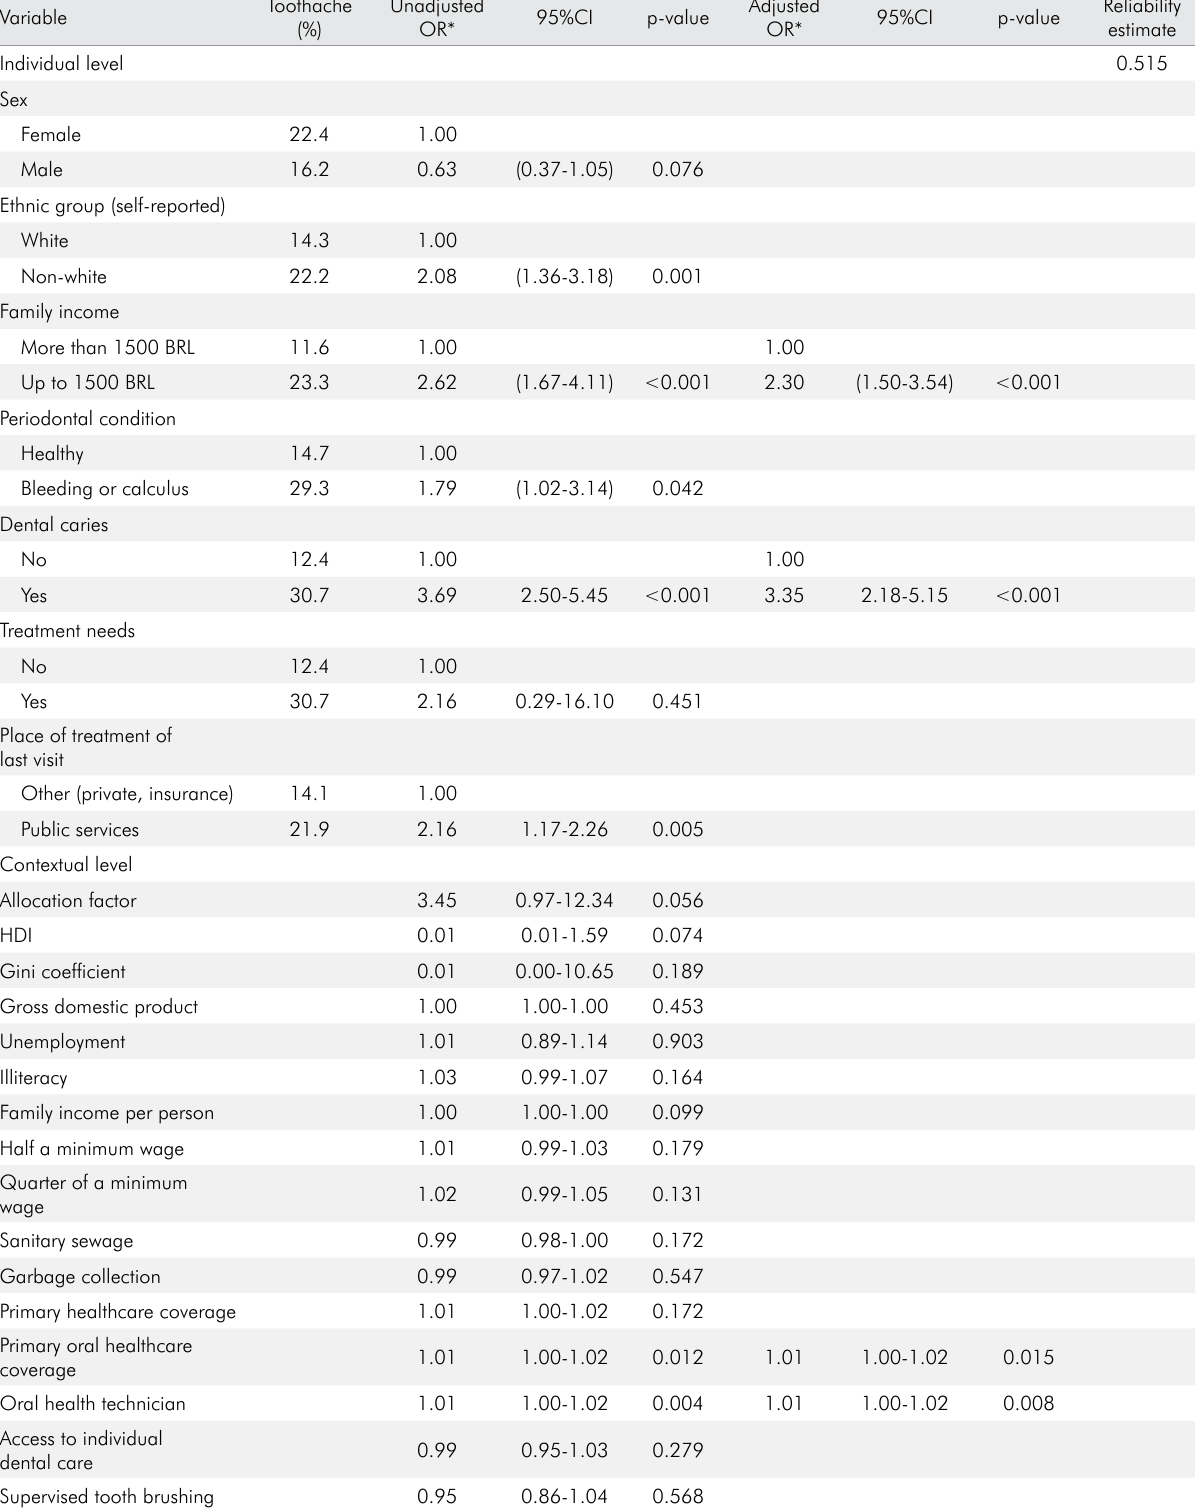
Table 5. Multilevel models (unadjusted and adjusted) for variables of individual (n =1,002) and contextual levels associated with the toothache of adolescents (12 years old), taken from a southeastern state of Brazil, 2012